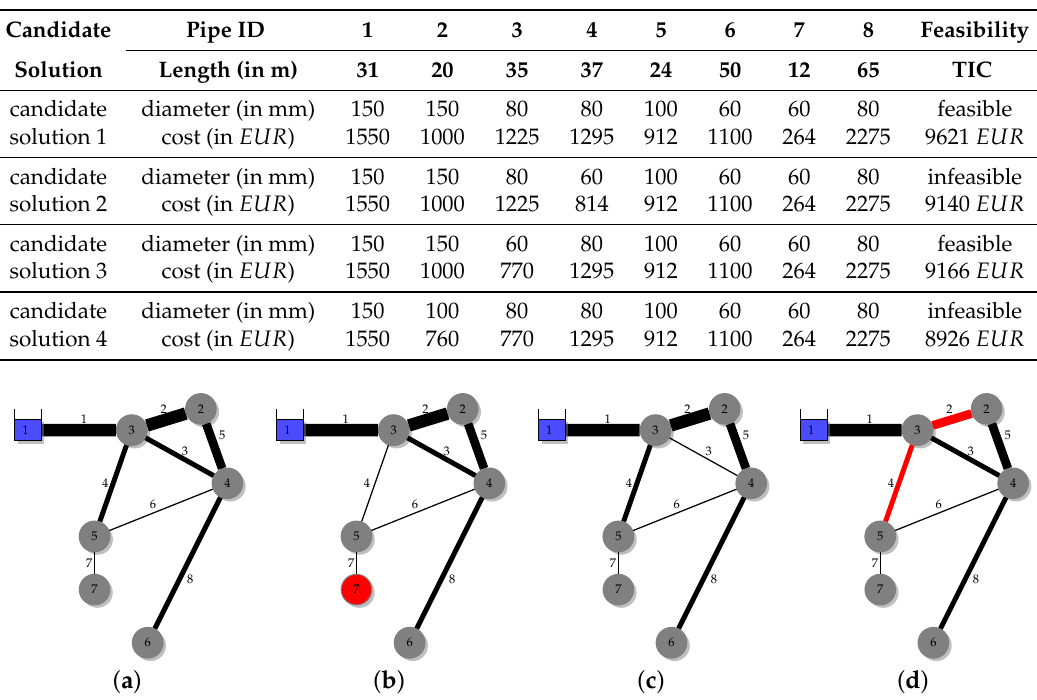
Figure 3. Different solutions or network designs in network representation. ( a ) Candidate solution 1; ( b ) Candidate solution 2; ( c ) Candidate solution 3; ( d ) Candidate solution 4.